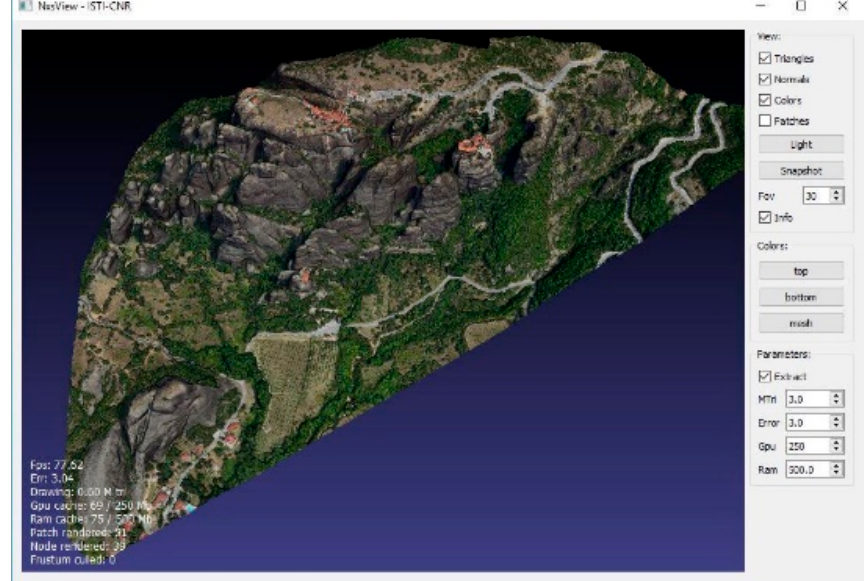
Figure 1. A multi-resolution model in the graphical interface of nxsview tool.